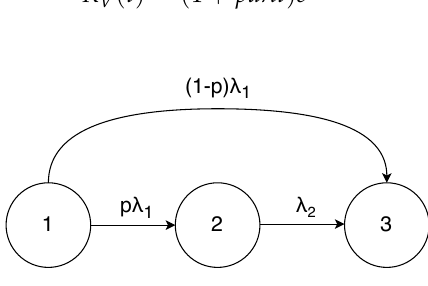
Figure 7. State transition diagram for reliability